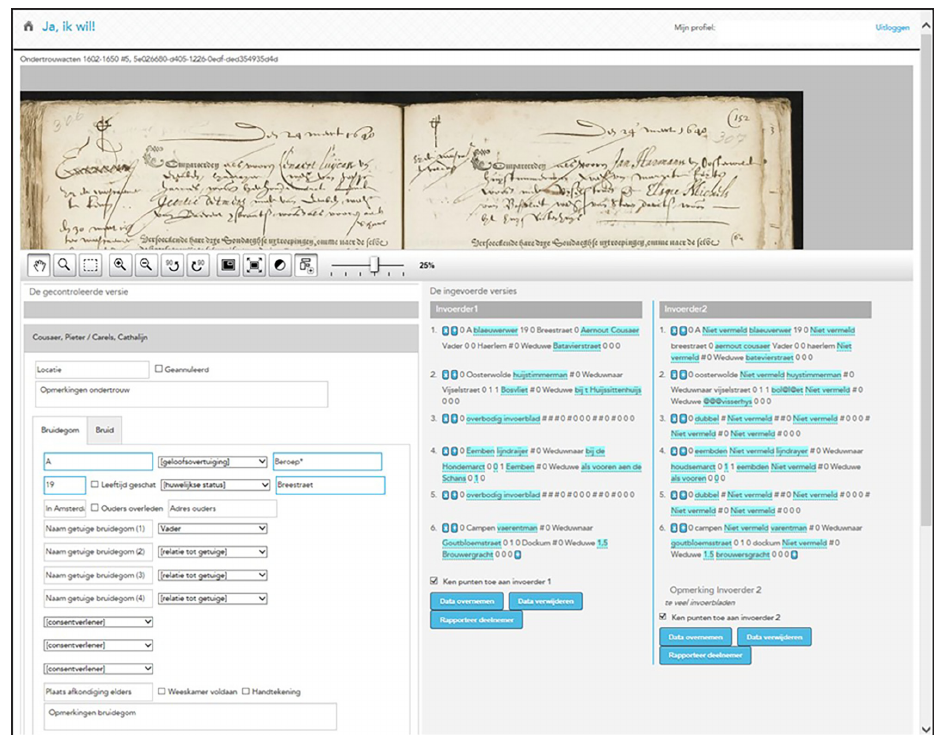
Figure 1: Online tool for checking and correcting entries. Source: Vele